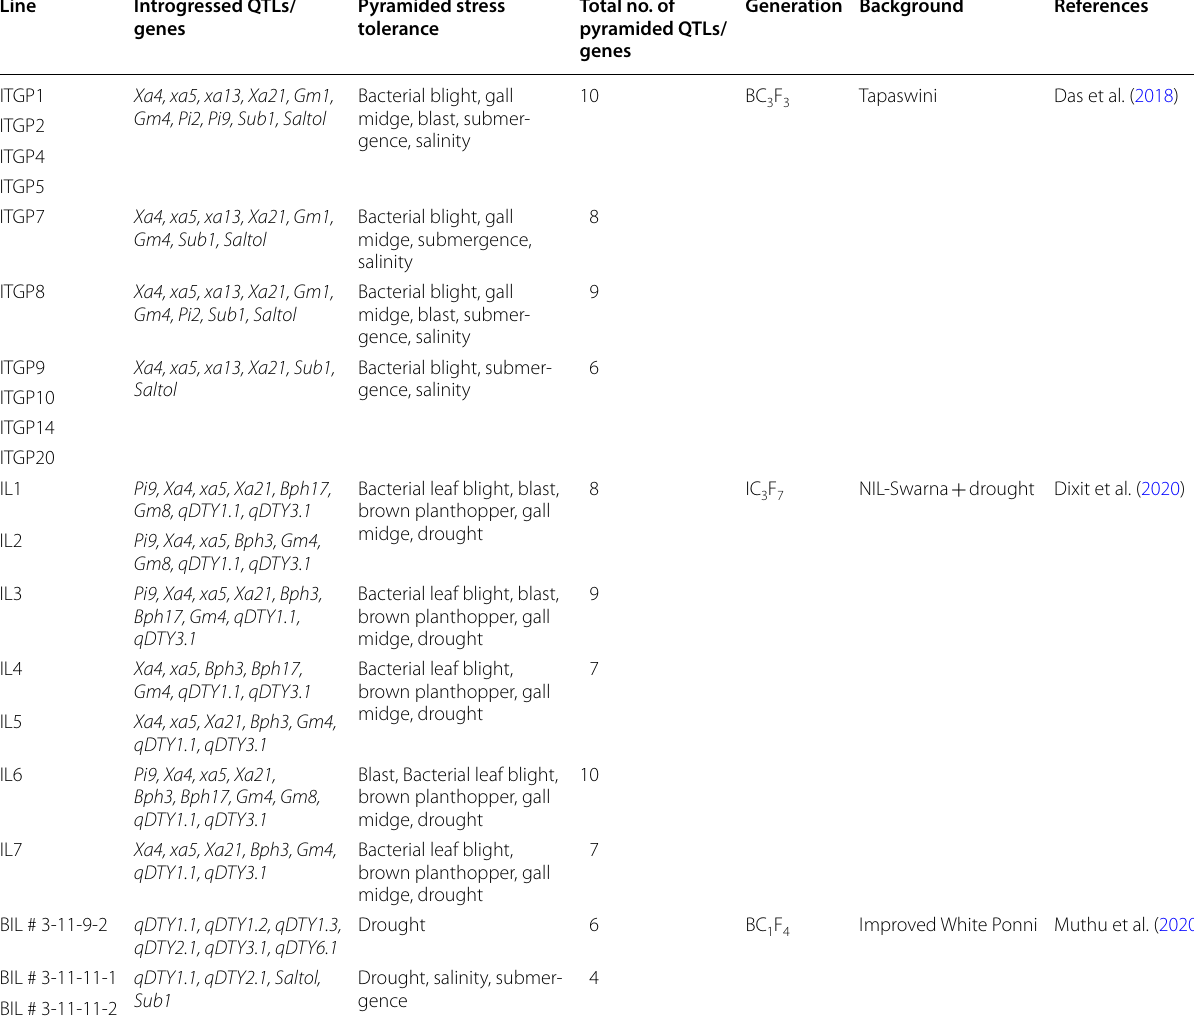
Table 3 Combination of multi‑stress resistant QTLs/genes with superior quality